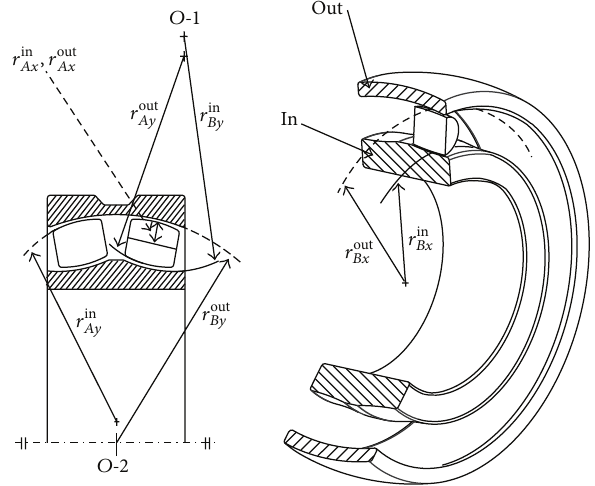
Figure2:Radiiofcurvatureforsphericalrollerbearingcomponents